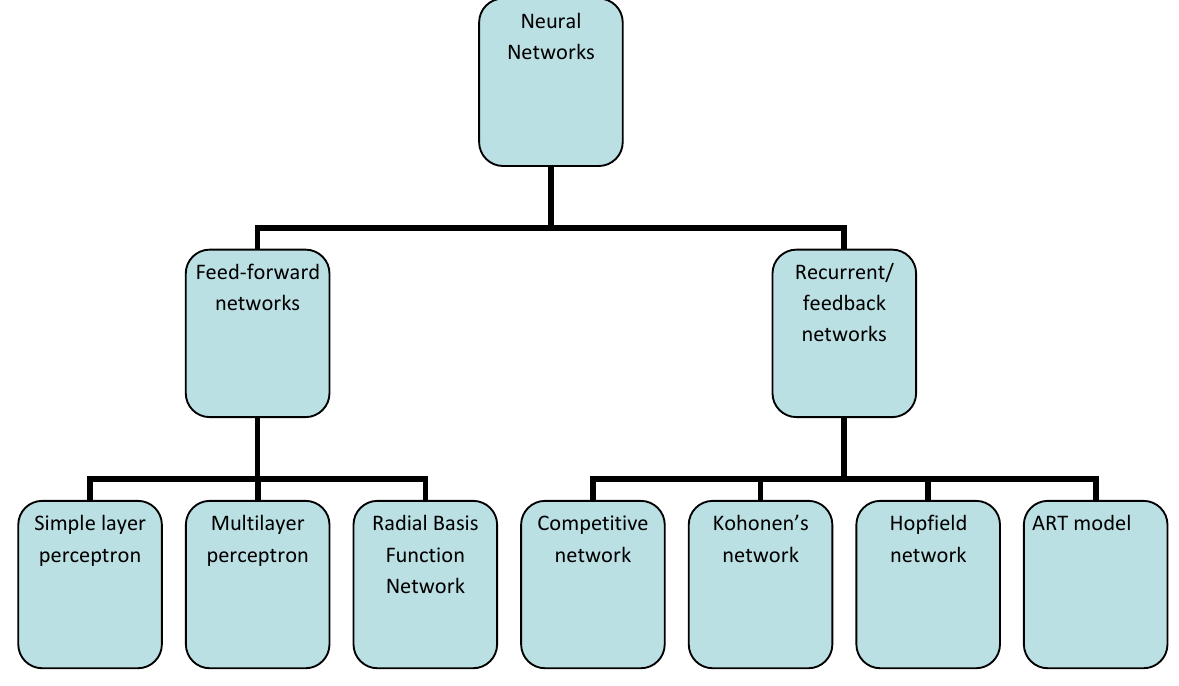
Fig. 4. The architecture of artificial neural networks (after Jain et al.,